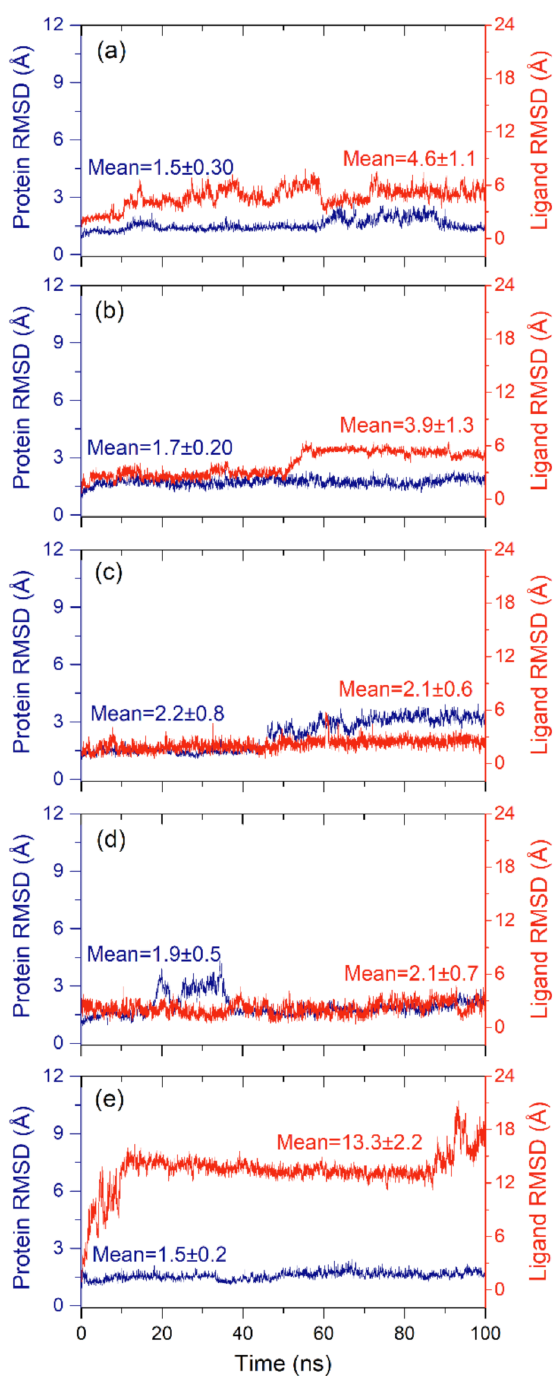
Figure 4. RMSD plots for the alpha carbon atoms (blue curves) of SARS-CoV-2 M pro and protein fit ligand (red curves) were computed for the docked complexes of SARS-CoV-2 M pro with selected compounds: ( a ) licuraside, ( b ) glucoliquiritin apioside, ( c ) 7,3 (cid:48) -Dihydroxy-5 (cid:48) -methoxyisoflavone, ( d ) licuroside, and ( e ) glycyrrhizin, obtained from the 100 ns MD simulation